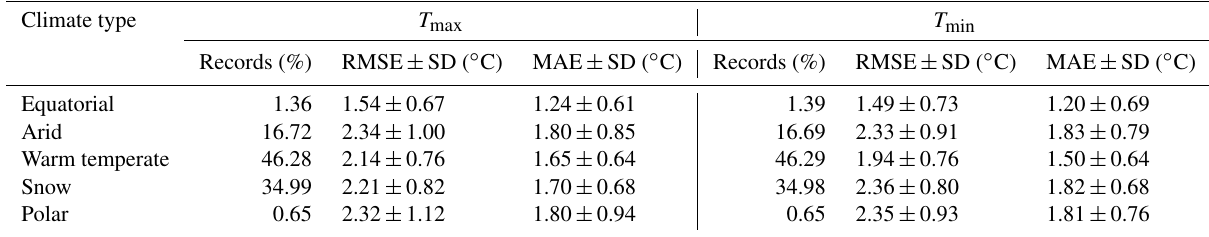
Table 4. Model performance for different climate types in 2003–2020.